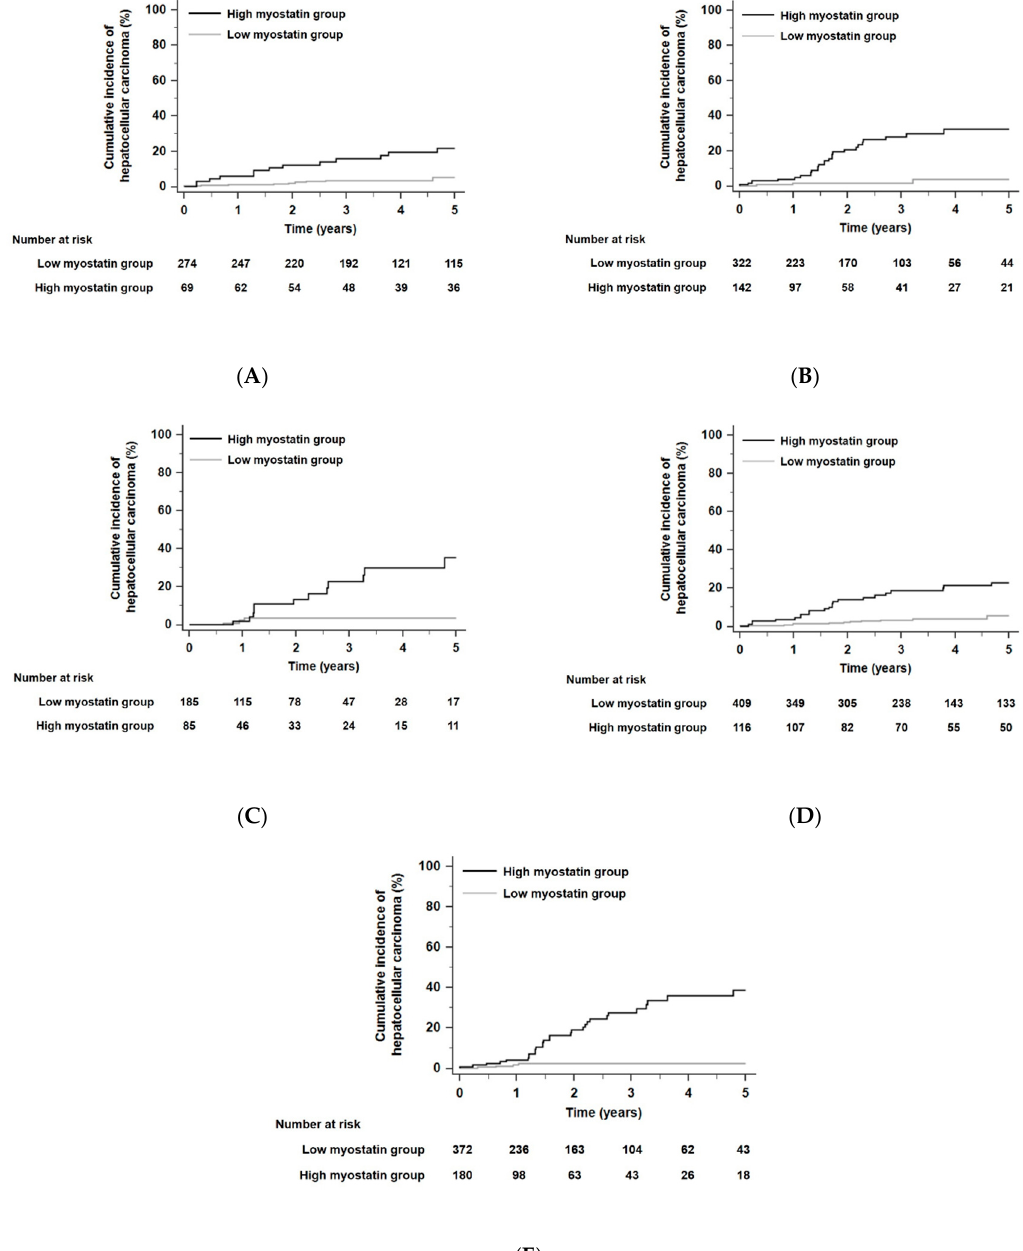
Figure 3. Kaplan–Meier estimates of HCC development in ALC patients in each group who had similar residual liver function according to Child–Pugh class or model for end-stage liver disease (MELD) scores. Risk stratification for HCC development according to serum myostatin levels among patients who were in Child–Pugh class A ( A ), class B ( B ), and class C ( C ) (all, p < 0.001 by log-rank test). Risk stratification for HCC development according to serum myostatin levels among patients who had low MELD scores ( ≤ 13, median value) ( D ) and high MELD scores ( > 13) ( E ) (all, p < 0.001 by log-rank test). Abbreviations: ALC, alcoholic liver cirrhosis; HCC, hepatocellular carcinoma; MELD, model for end-stage liver disease.